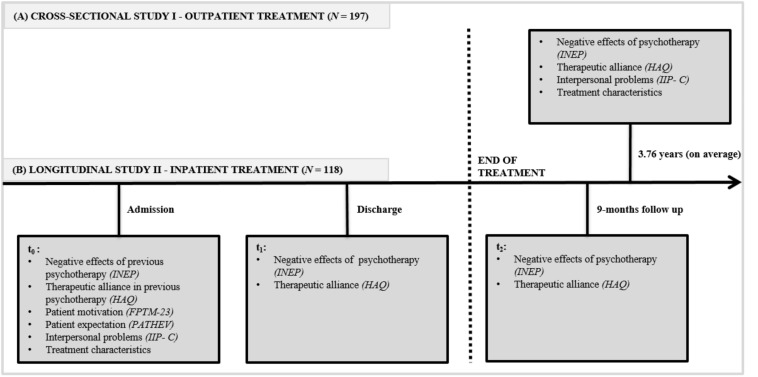
Study designs of (A) the cross-sectional study I and (B) the longitudinal study II. INEP, Inventory for the Balanced Assessment of Negative Effects of Psychotherapy; HAQ, German version of the Helping Alliance Questionnaire; IIP-C, German version of the Inventory of Interpersonal Problems; FPTM-23, German version of the Questionnaire on Psychotherapy Motivation; PATHEV, Patient questionnaire on Therapy Expectation and Evaluation; t0, at admission; t1, at discharge; t2, 9-months follow-up assessment post-treatment.